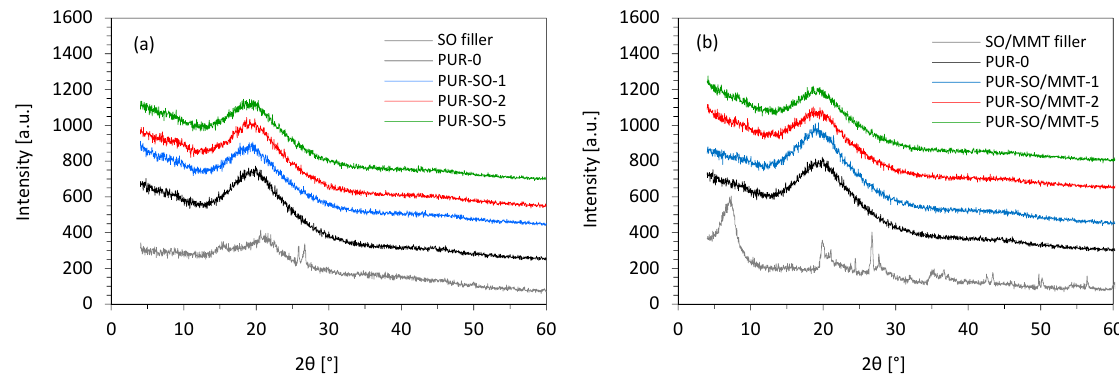
Figure 9. XRD patterns of PUR composites reinforced with ( a ) unmodified SO filler, and ( b ) MMT-modified SO filler.